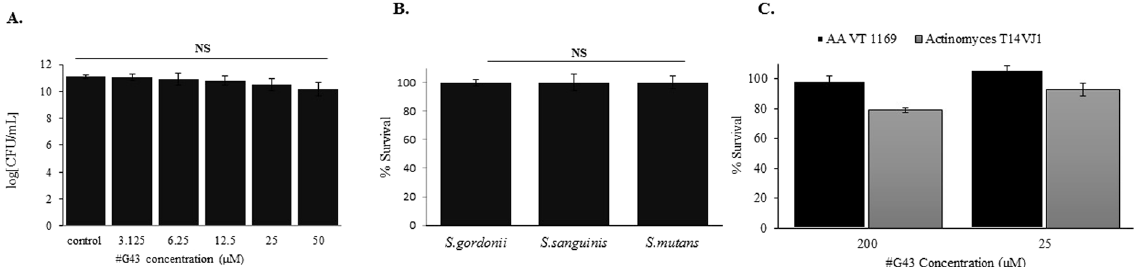
Figure 5. Effects of the lead compound #G43 on cell viability. ( A ) Effects on S. mutans . S. mutans was treated with DMSO and a serial dilution of #G43. The cell viability was determined by the numbers of CFU in a logarithmic scale. ( B ) Effects on commensal species. S. gordonii , S. sanguinis , and S. mutans were treated with 200 µ M of the compound or DMSO, and bacterial growth was measured at OD 470 , and normalized to the DMSO control (100%). ( C ) Effects on Aggregatibacter actinomycetemcomitans and Actinomyces naeslundii . A. actinomycetemcomitans and A. naeslundii were treated with the lead compound at 200 µ M or 25 µ M or DMSO control, bacterial growth was measured at OD 470 , and normalized to the DMSO control (100%). Values represent the means ± standard deviations from three independent experiments. NS indicates that the cell viability between DMSO control and compound-treated groups was not significantly different. The P value > 0.05 is considered to be not significant.